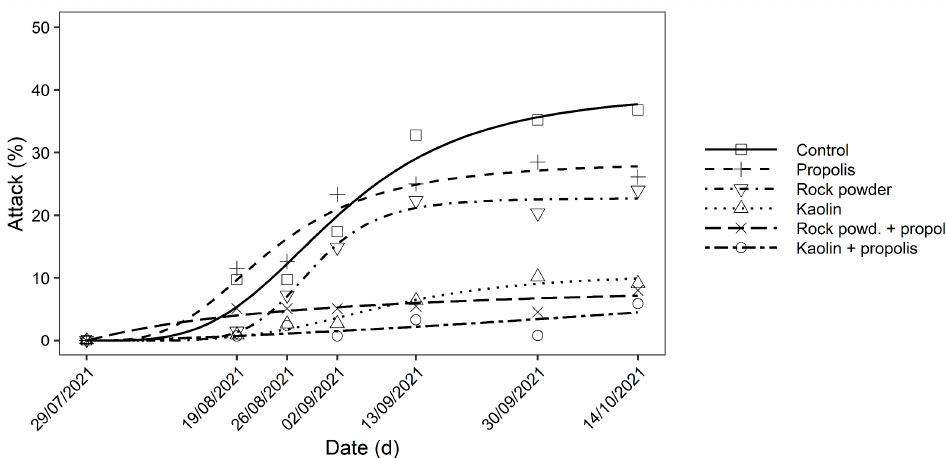
Figure 1. Seasonal trends of olive fruits of the cultivar Borgiona attacked by Bactrocera oleae in treated and control branches. Symbols represent observed mean percentage of raw data. Lines represent predictions from the fitted model. Data were analyzed by means of three-parameter nonlinear mixed effects model. Likelihood ratio test was used to evaluate differences among treatments and control ( p ≤ 0.05). Significant differences were detected among curves, except for control vs. propolis and for kaolin vs. rock powder and propolis mixture.